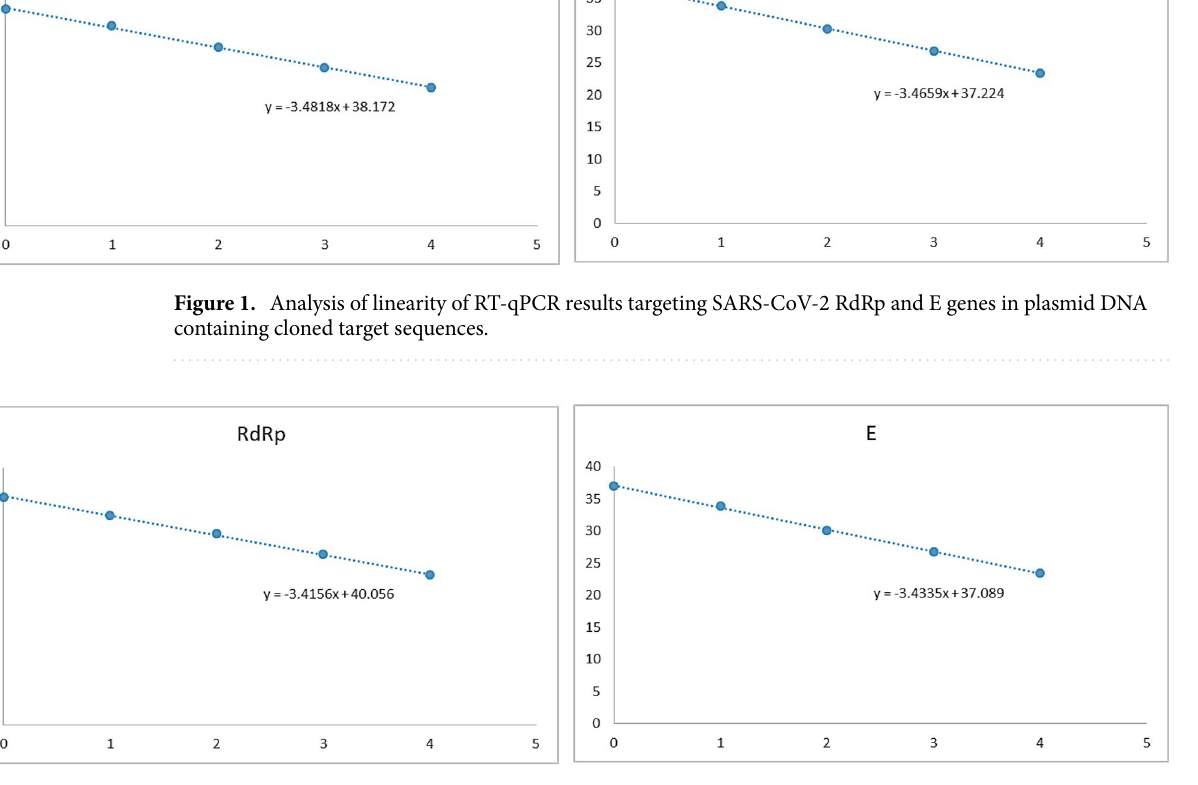
Figure 2. Analysis of linearity of RT-qPCR results targeting SARS-CoV-2 RdRp and E genes in RNA isolated from a nasopharyngeal swab used in testing the first patient confirmed to have COVID-19 in South Korea.